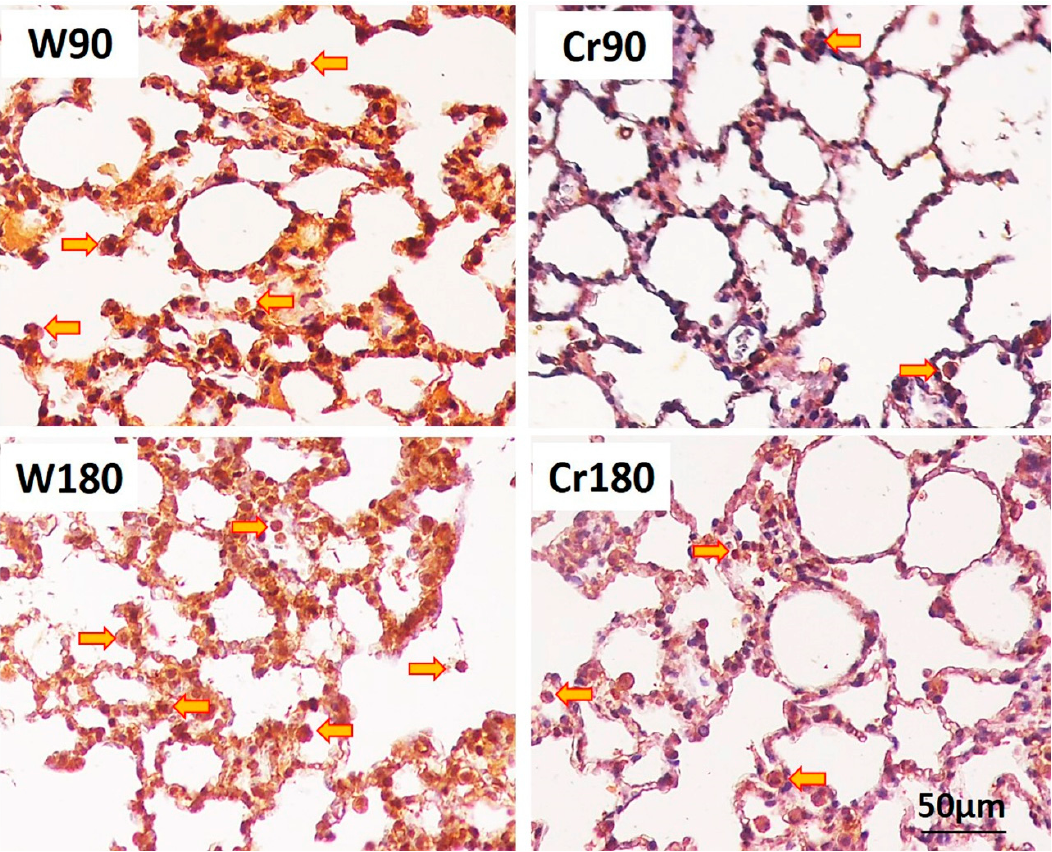
Figure 6. Apoptosis cells in the lung tissue. W90, control/water + 90 min of ischemia; Cr90, creatine + 90 min of ischemia; W180, control/water + 180 min of ischemia; Cr180, creatine + 180 min of ischemia. Orange arrow, macrophages and neutrophils. Photomicrographs of the lung parenchyma stained by Caspase-3 immunohistochemistry (400×).